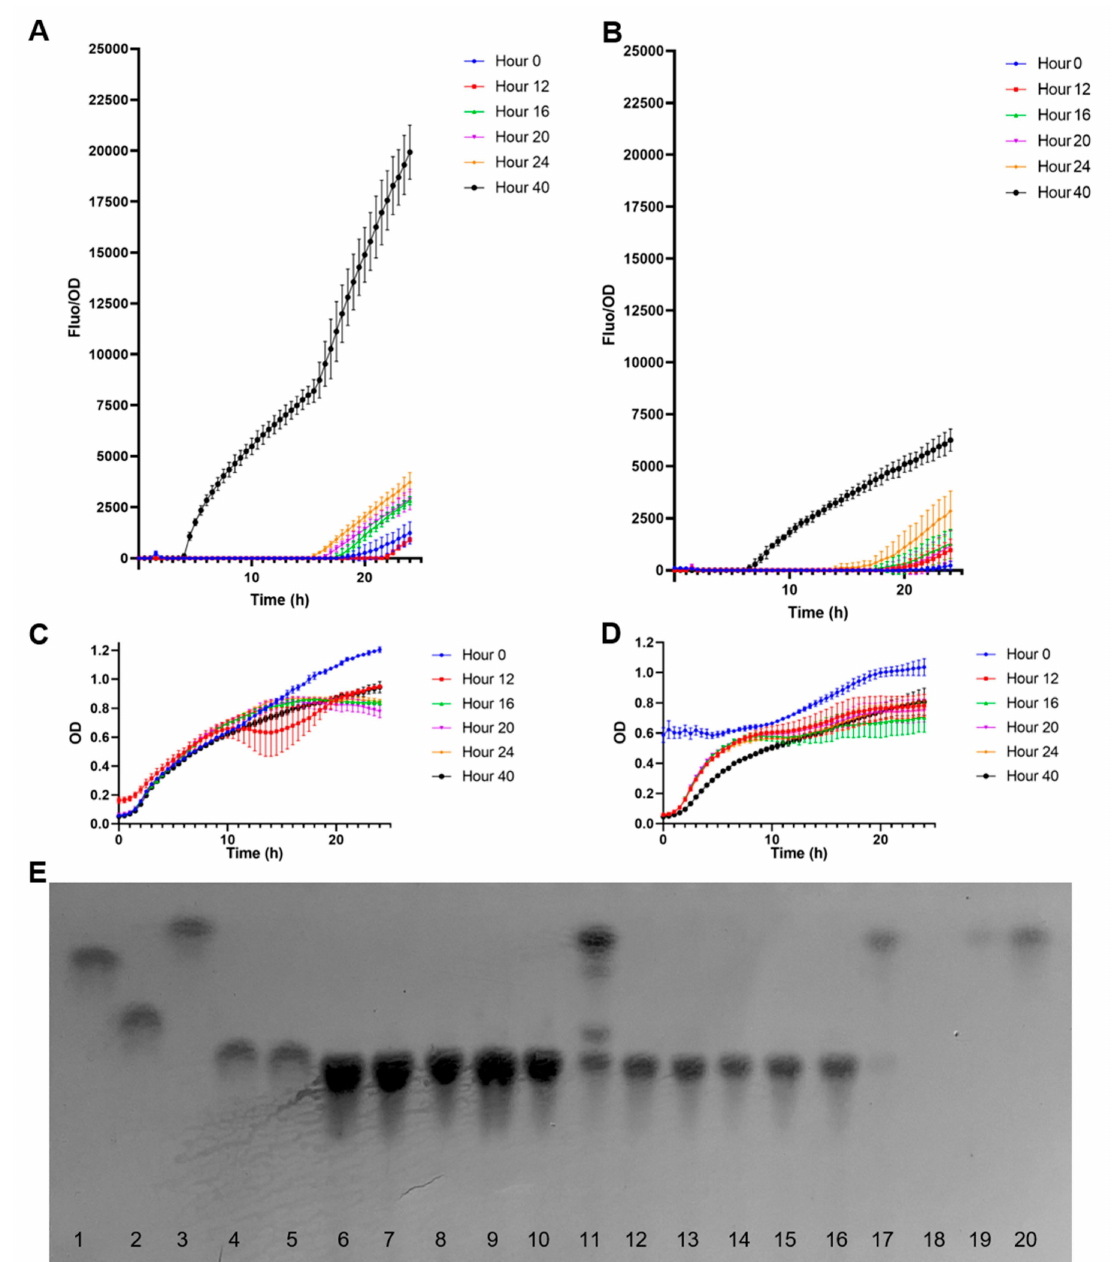
Figure 6. Quantification of fucose in B. bifidum supernatants using the biosensor E. coli BL21 pFuc + FucR colE1. ( A ) Normalized F/OD values for supernatants after growth in 2FL; ( B ) Normalized F/OD values for supernatants after growth in 3FL; ( C ) growth curves of the biosensors in the presence of supernatants from B. bifidum grown in 2FL; ( D ) growth curves of the biosensors in the presence of supernatants from B. bifidum grown in 3FL; ( E ) TLC analysis of B. bifidum supernatants. Standards used were 1: galactose, 2: lactose, 3: fucose, 4: 2FL, 5: 3FL, at 1 mg/mL. 6–11: supernatants from 2FL growth at 0 (6), 12 (7), 16 (8), 20 (9), 24 (10), and 48 h (11). 12–17: supernatants from 3FL growth at 0 (12), 12 (13), 16 (14), 20 (15), 24 (16), and 48 h (17). Lane 19 corresponds to 1 mM fucose, and lane 20 to 10 mM fucose. Kinetics and growth values shown correspond to average ± SD; n =